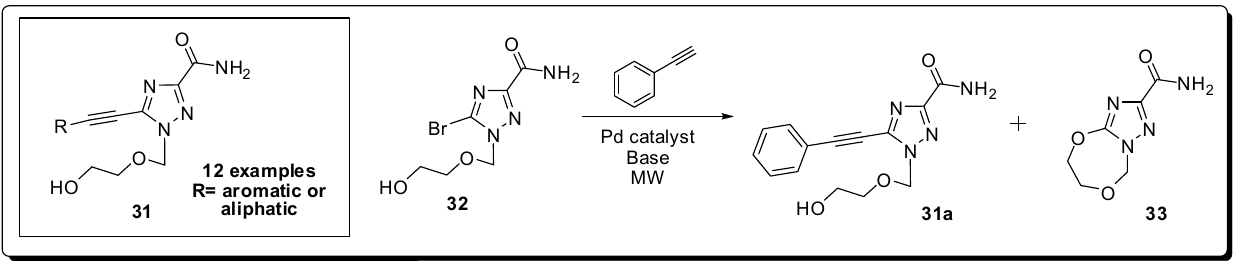
Figure 10. Synthesis of a series of compounds designed against the hepatitis C virus.